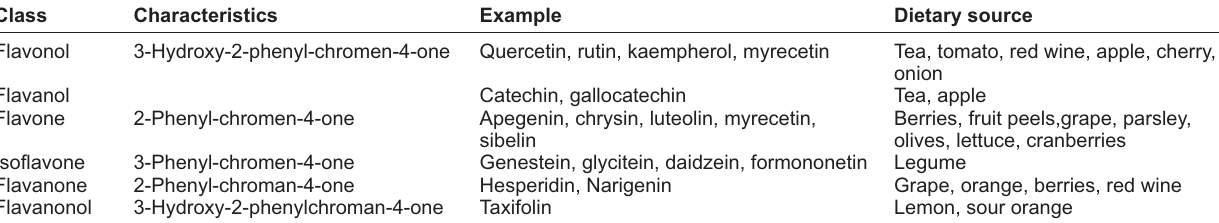
Table-1. Classification of flavonoids and their dietary source (source: